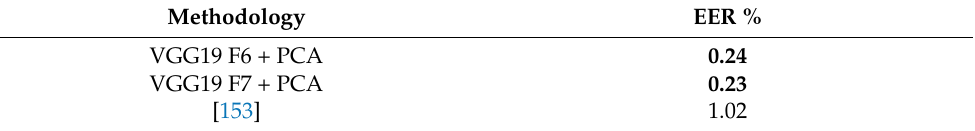
Table 17. Authentication EER of [153] compared to ours. Bold values signify the best